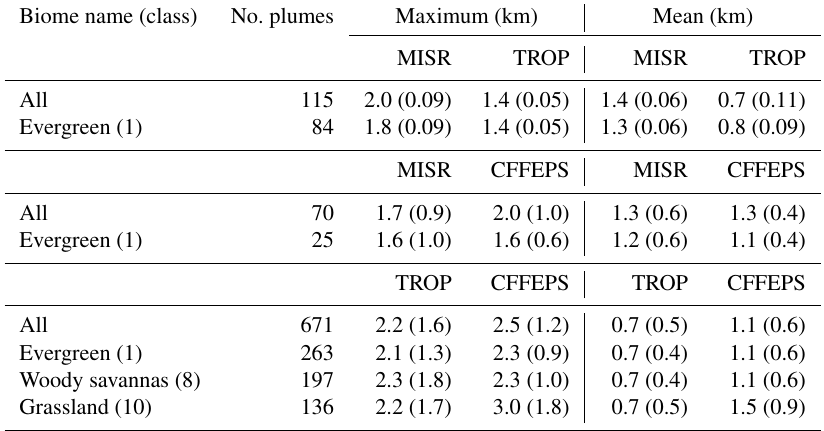
Table 1. Summary of plume heights observed in different regions; shown is the mean (standard deviation) of the maximum and mean plume heights for all plumes for different types of wildfires (IGBP biome). The reported altitudes are all in kilometres above ground